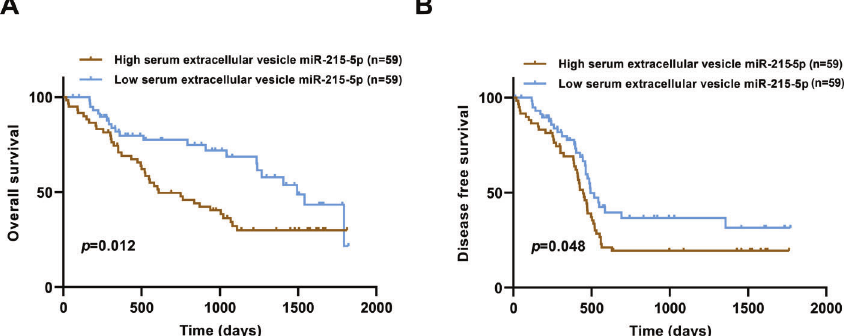
Figure 4 - Correlation between serum EV-miR-215-5p level and OS and DFS. (A) GC patients with high serum EV-miR-215-5p levels had shorter OS. (B) GC patients with higher serum EV-miR-215-5p levels had worse